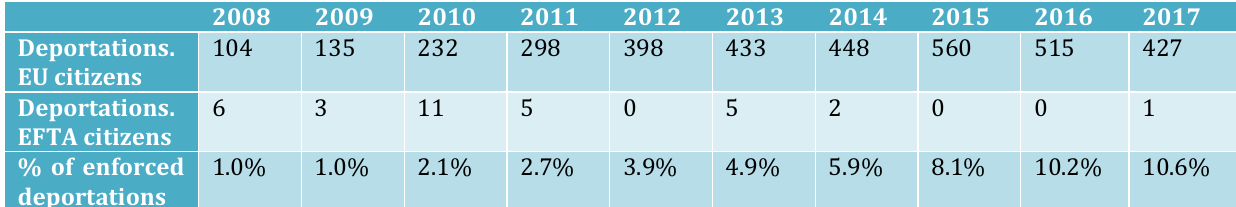
Table 2: Deportations of EU and EFTA citizens enforced in Spain, 2008-2017 2008 2009 2010 2015 2016 2017 Deportations. 232